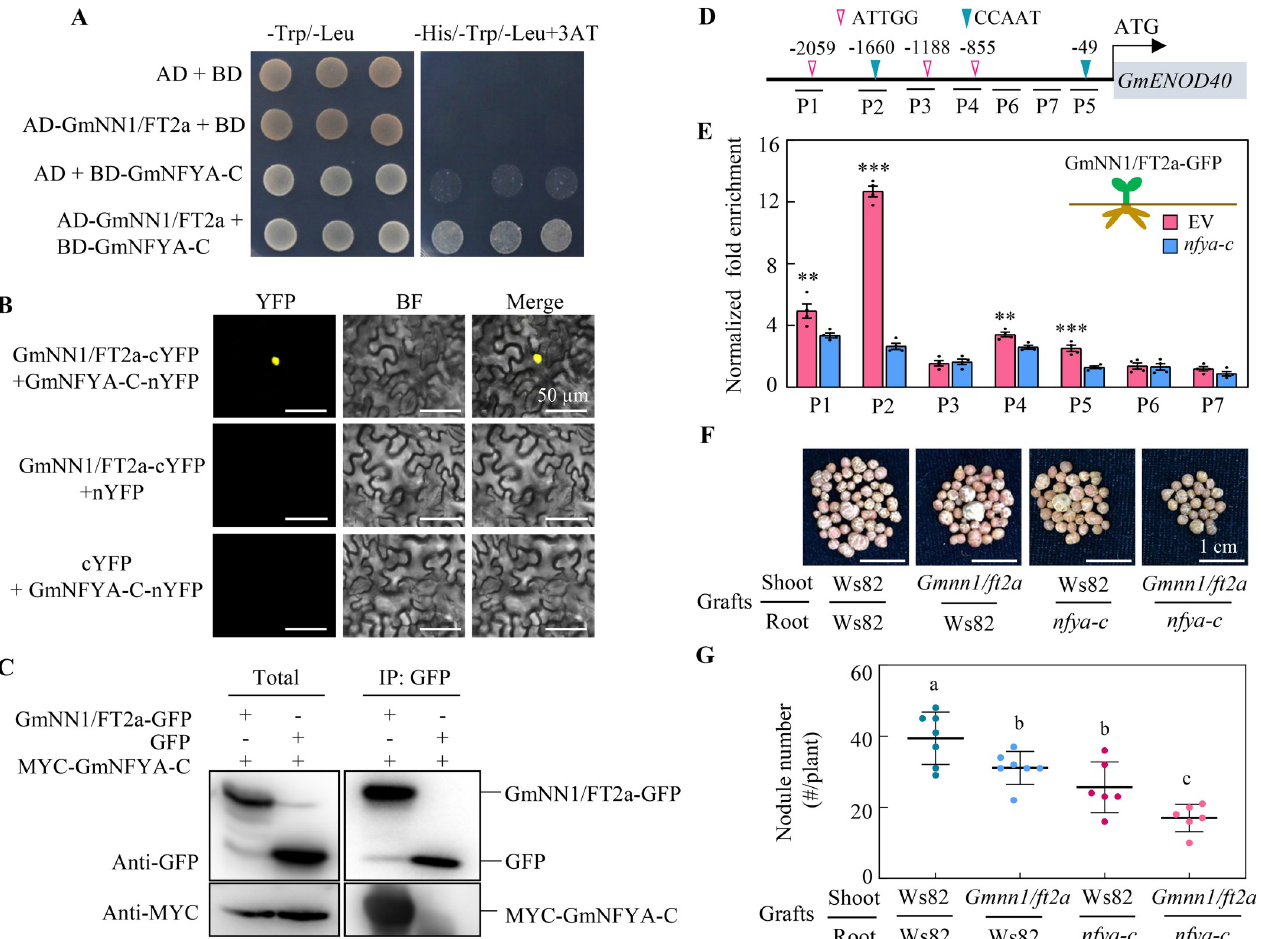
Fig 6. The GmNN1/FT2a-GmNFYA-C-GmENOD40 module regulates soybean nodulation. (A) Interaction between GmNN1/FT2a and NYFA-C in the yeast 2-hybrid assay. (B) GmNN1/FT2a and GmNFYA-C interaction in the nucleus of tobacco epidermal cells subjected to BiFC analysis. (C) GmNN1/FT2a interacting with GmNFYA-C in vitro pull-down assays. (D) Diagram of GmENOD40 promoter. The inverted triangles indicate binding sites of GmNFYA-C. P1 to P7 are the fragments selected for ChIP-qPCR. (E) ChIP assay of fragments in the promoter region of GmENOD40 ( n = 4). Soybean transgenic composite plants inoculated with rhizobia were grown in sand culture conditions for 5 dai. Hairy roots harboring EV or nfya-c mutant produced by CRISPR/Cas9 were separately collected for fixation. (F and G) Nodule performance and nodule number of grafts. Nodules were harvested at 21 dai. Gmnn1 / ft2a and nfya-c : stable transgenic soybean with knockout of GmNN1/FT2a and GmNFYA-C , respectively; Ws82: WT control. Data are given as mean ± SD ( n = 6–7). Different letters denote significant differences ( P < 0.05) according to Duncan’s multiple range comparison tests. Data underlying the graphs in the figure can be found in S1 Data. BF, bright field; ChIP, chromatin immunoprecipitation; dai, day after inoculation; EV, empty vector; Merge, overlay of the YFP and bright field images; WT, wild type.